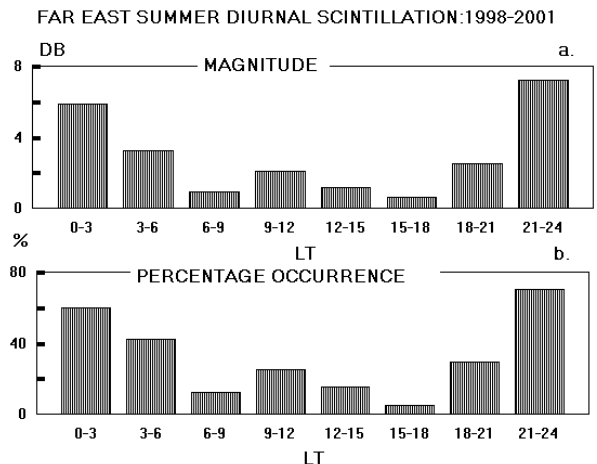
Fig. 4. The summer average diurnal scintillation magnitude and percentage occurrence of scintillation events at the indicated LT in- tervals as recorded at